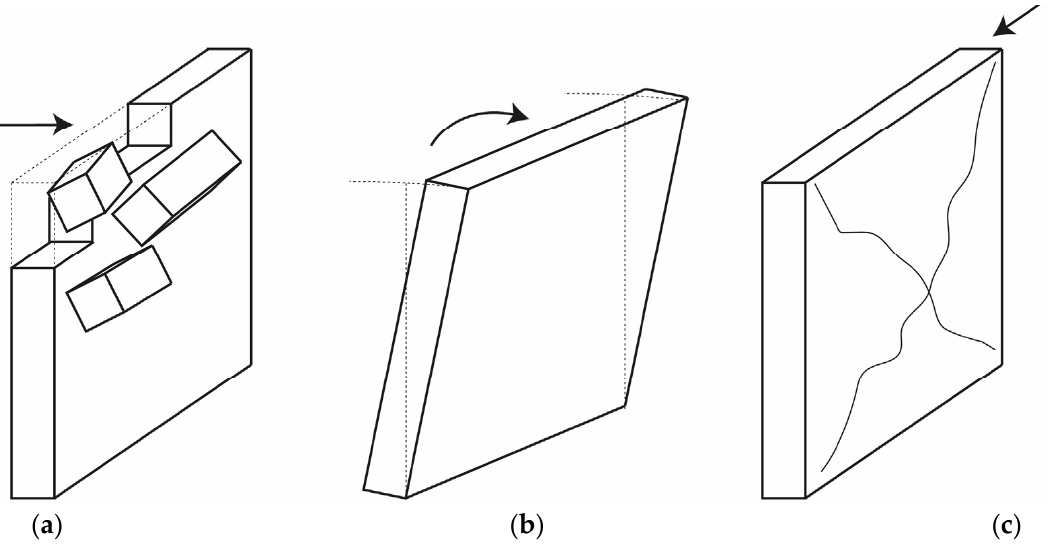
Figure 3. Masonry failure mechanisms—( a ) masonry disintegration, ( b ) out-of-plane kinematic mechanism, and ( c ) in-plane failure.